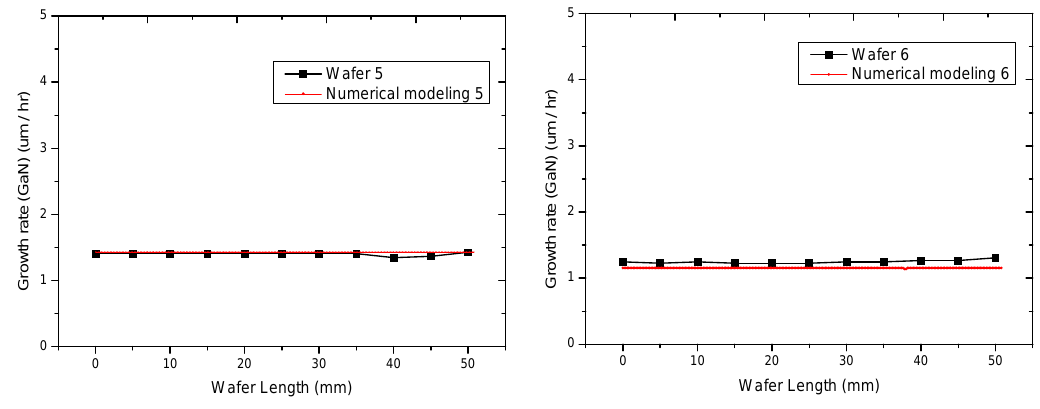
Figure 8. Predicted growth rates for wafers 5 and 6 vs. experimental results.